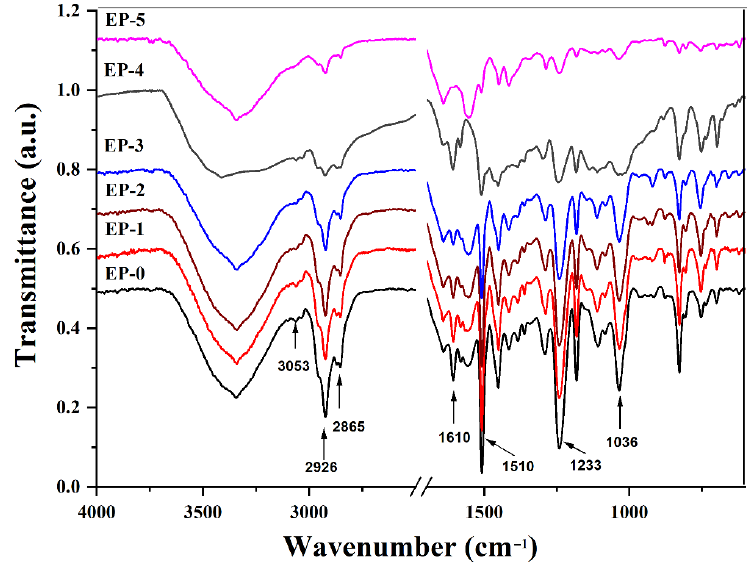
Figure 5. FTIR spectra of EP epoxy composites.